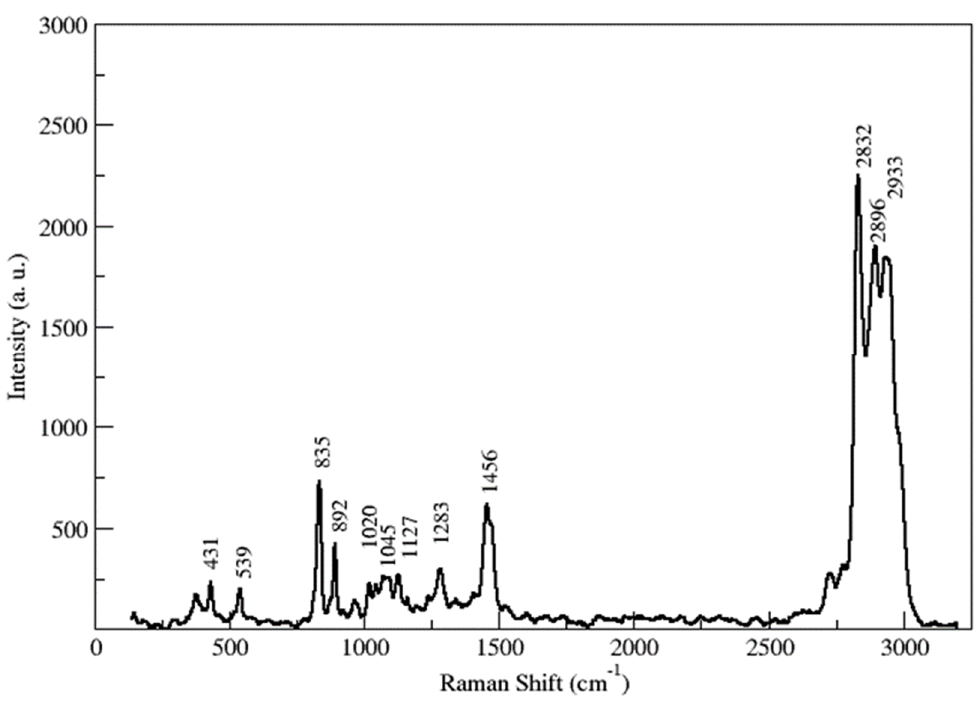
Figure 11. Raman spectrum of room temperature 2-methoxyethan-1-ol.